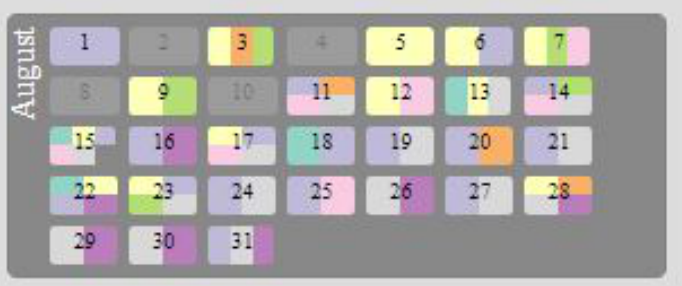
Figure 10. Overview of days with written texts of August 1944 after loading the concept of women and camp.